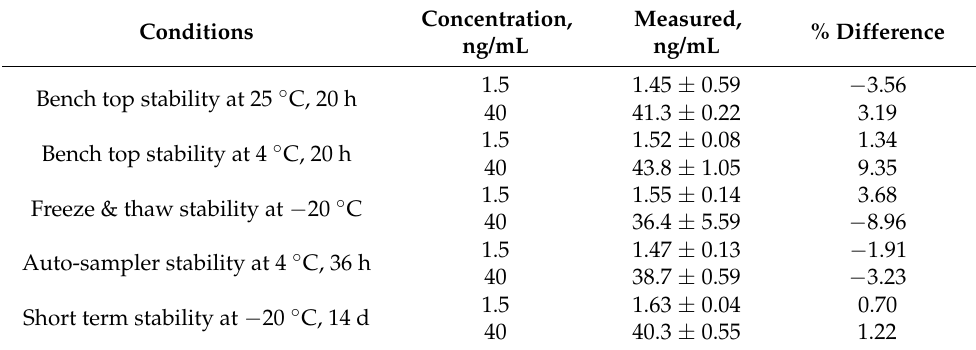
Table 3. Stability of colchicine in plasma under various conditions ( n =